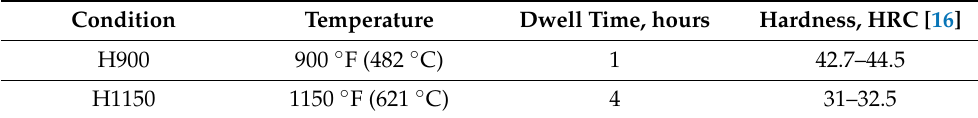
Table 3. Details of the H900 and H1150 precipitation hardening treatments after standard solutioning (1025–1050 °C).